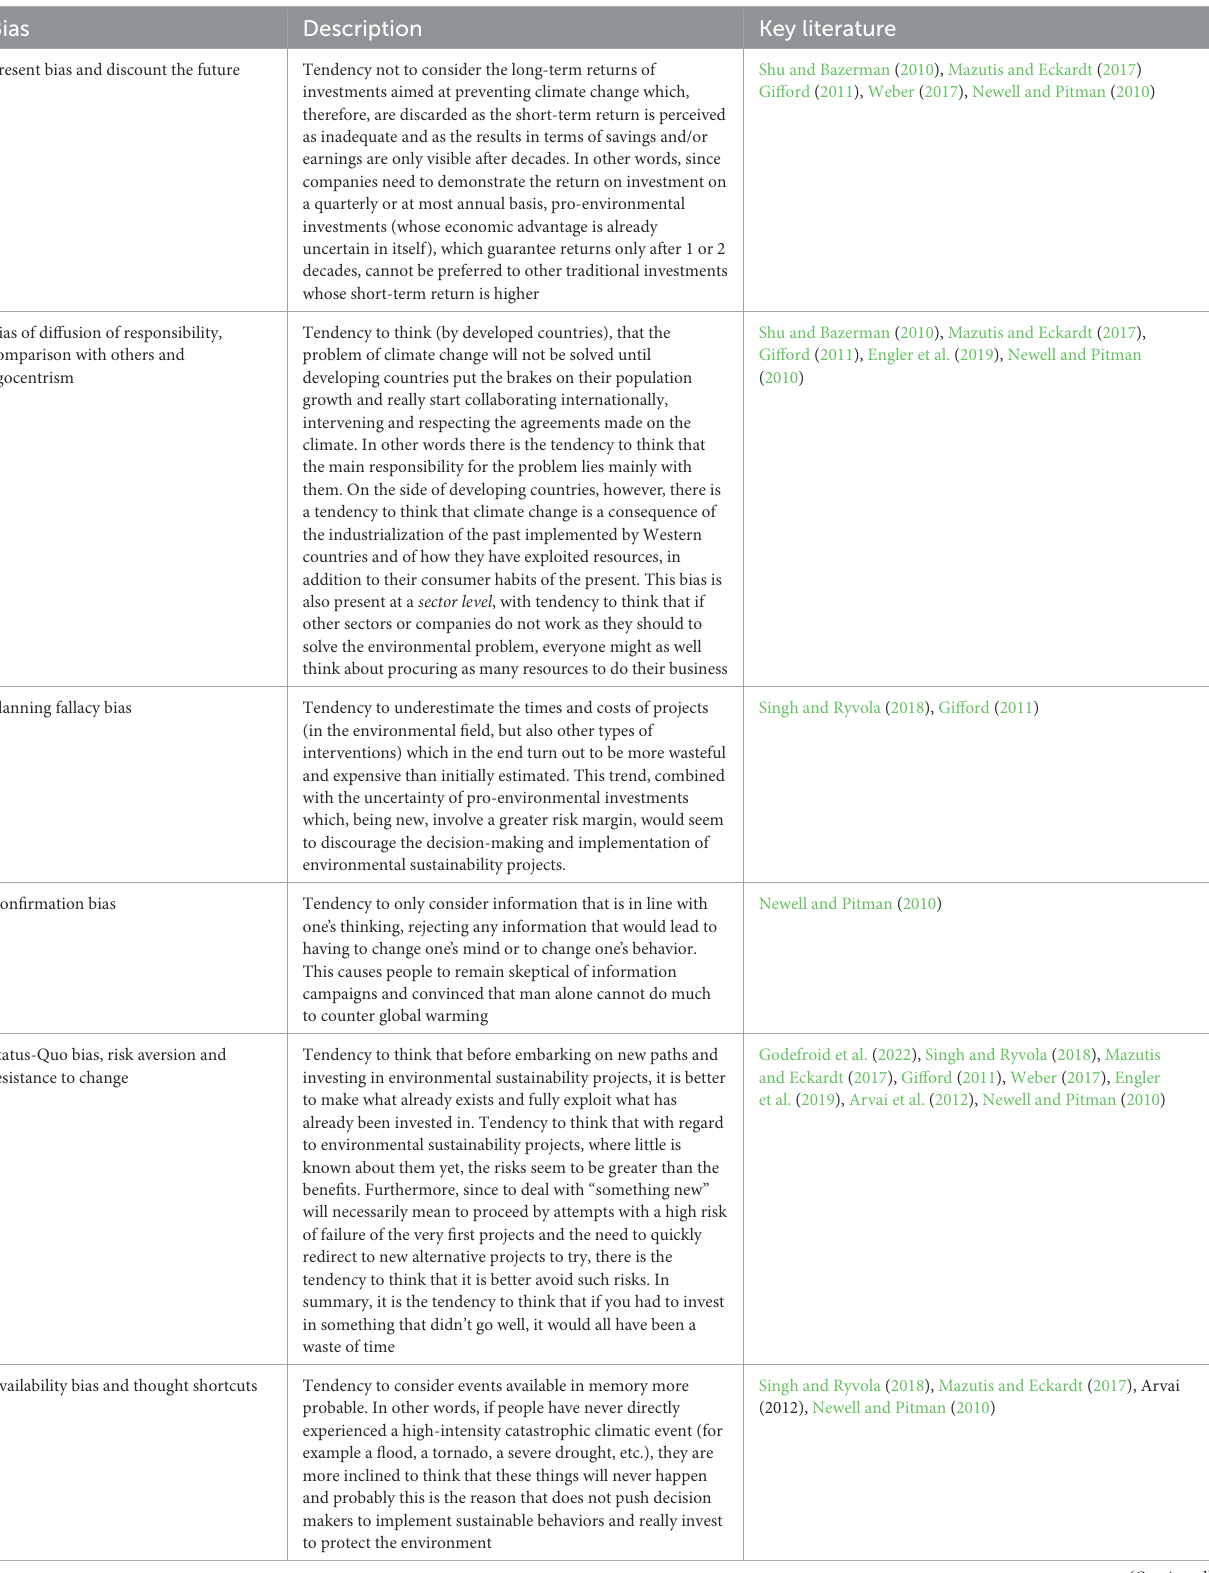
TABLE 1 List of the main biases which have an influence on the decision-making regarding the implementation of pro-environmental behaviors.